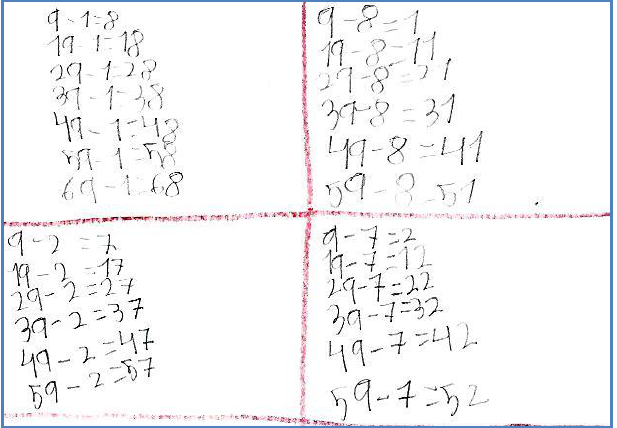
Figure 18. Example of arithmetic pattern in subtraction.